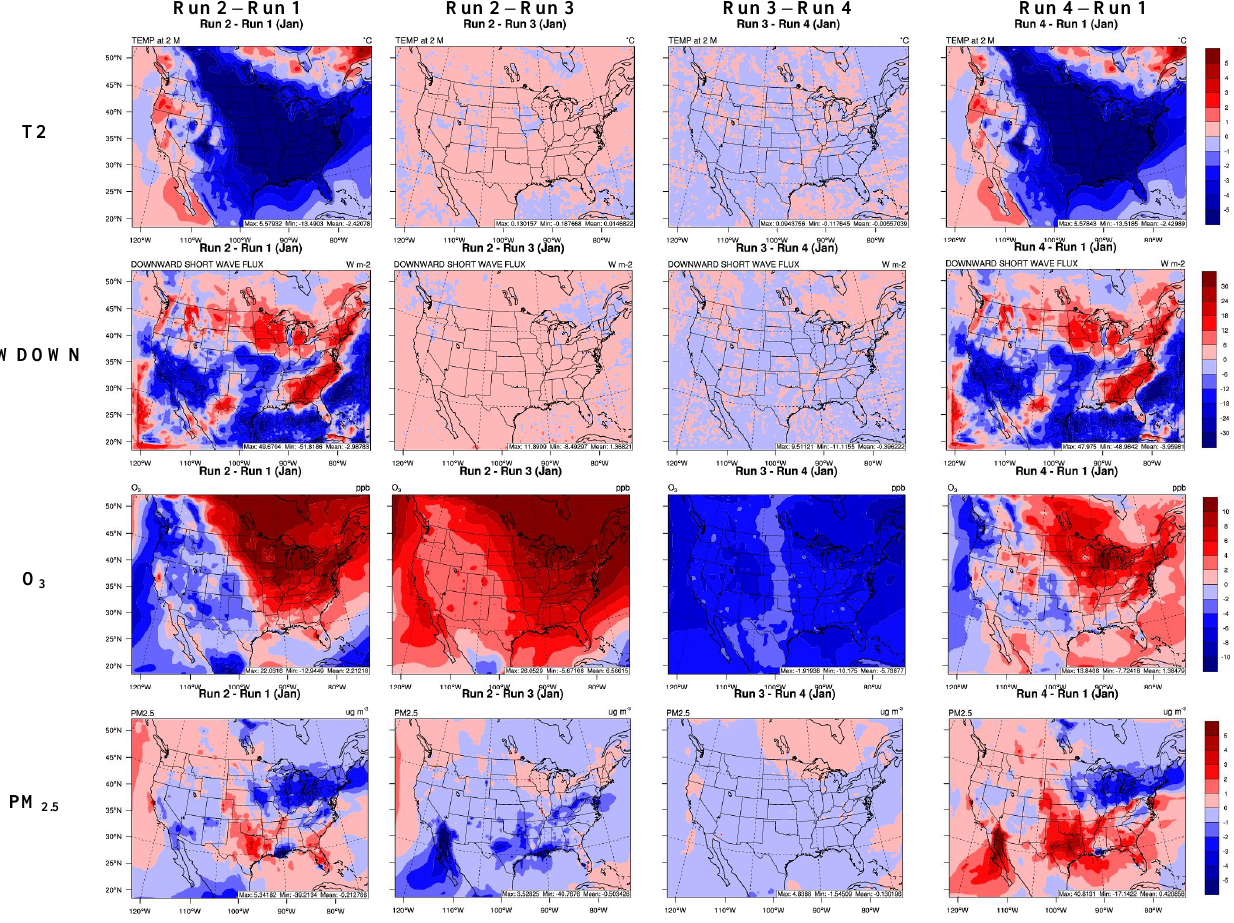
Figure 13. Spatial difference plots for January. Run 1: 2006 baseline simulations; Run 2: 2010 baseline simulations; Run 3: 2010 simulations with 2006 emissions and 2010 meteorology and chemical ICONs/BCONs; Run 4: 2010 simulations with 2006 emissions and 2006 chemical ICONs/BCONs and 2010